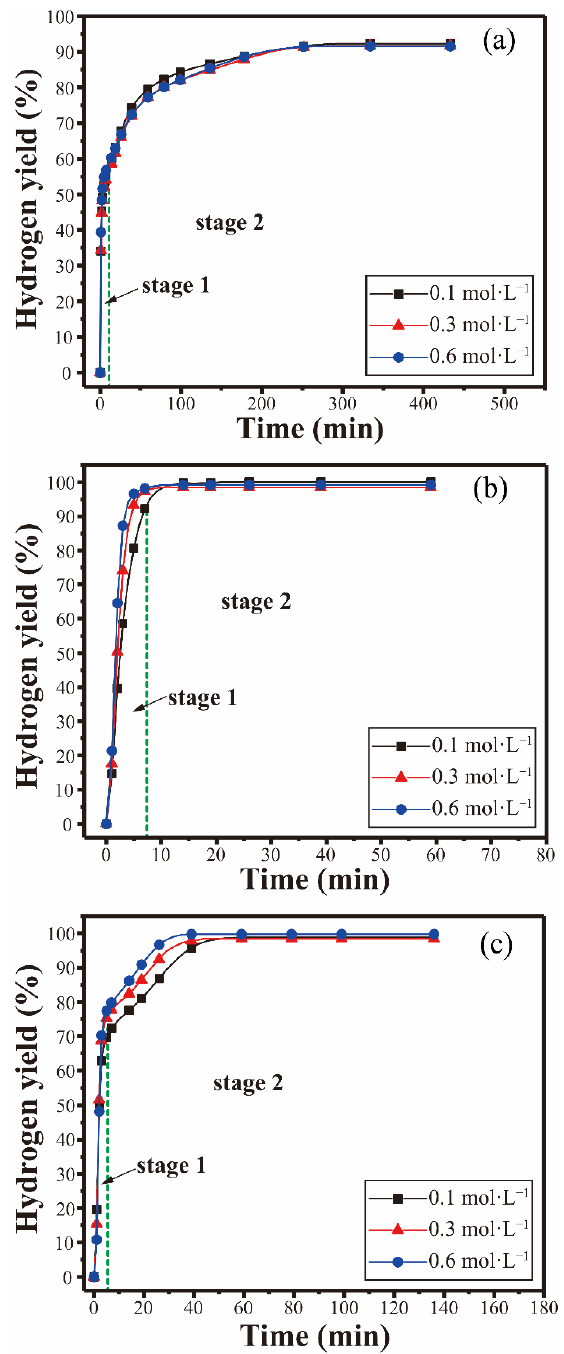
Figure 8. Hydrogen generation curves of the Al-Bi-Sn-Fe composite powders reacting with NaCl solutions of different concentrations at 50 ◦ C: ( a ) Al-10Bi-7Sn-0.5Fe (wt.%); ( b ) Al-10Bi-7Sn-1.5Fe (wt.%); ( c ) Al-10Bi-7Sn-3Fe